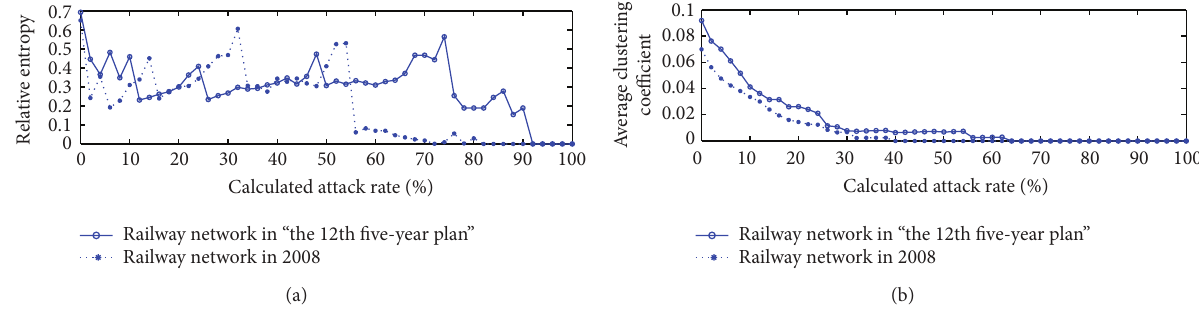
Figure 5: Relative entropy and average clustering coefficient change of railway network under deliberate